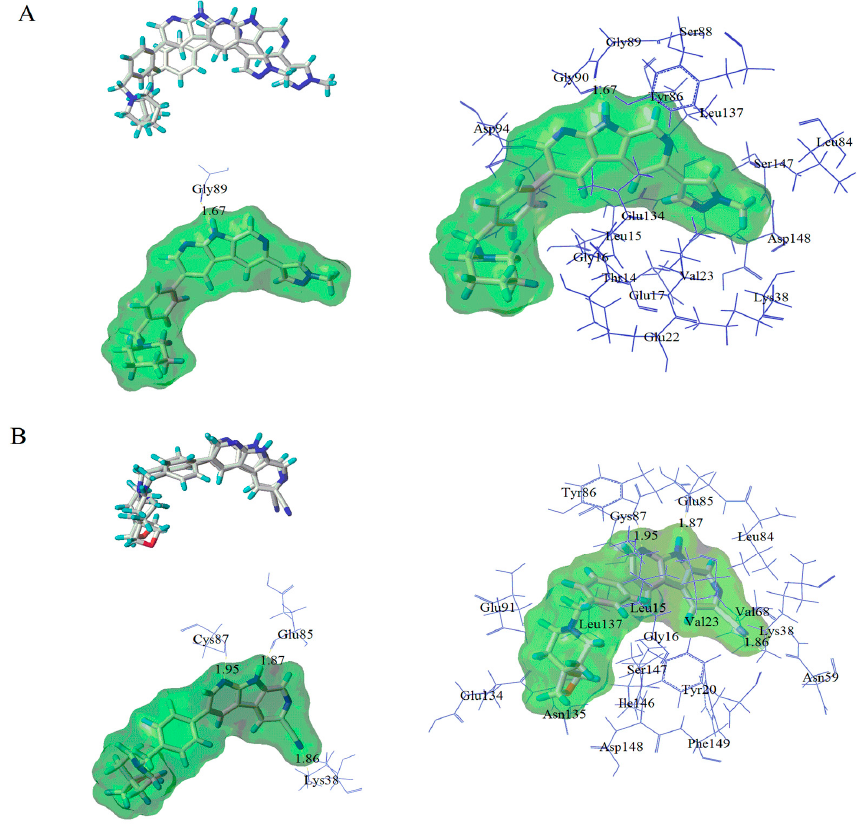
Figure 12. The alignment of molecular dynamics simulated and original ligand, as well as the docking results of compound 28 ( A ) and 17 ( B ).